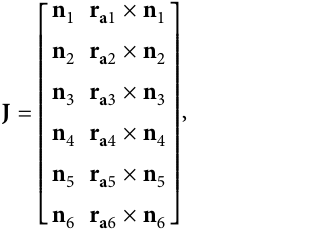
wi relative to $ ti